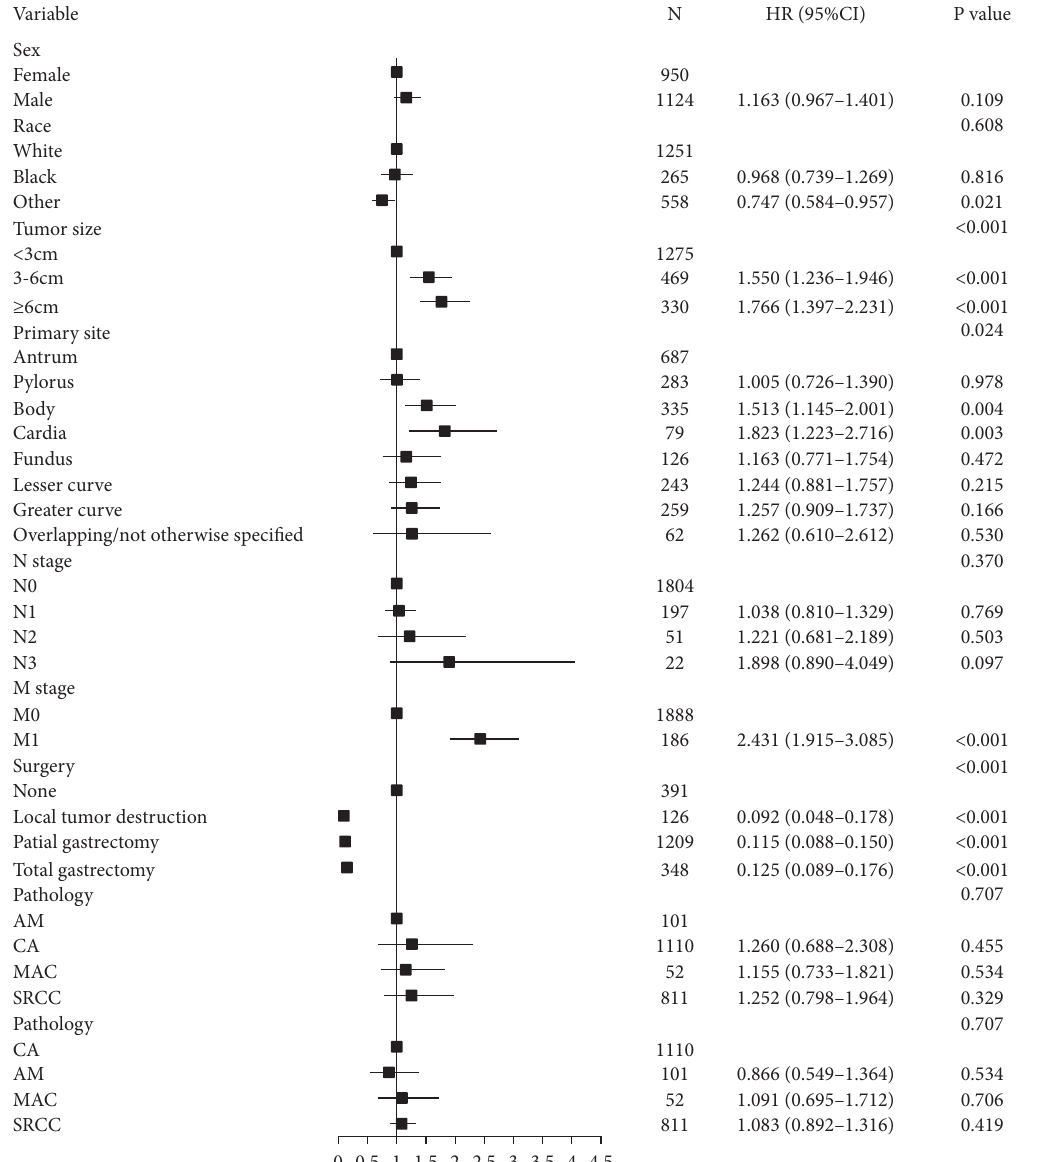
Figure 2: Forest plot showing results of the multivariate Cox regression model for the cancer-specific survival of histologic subtypes in early gastric cancer